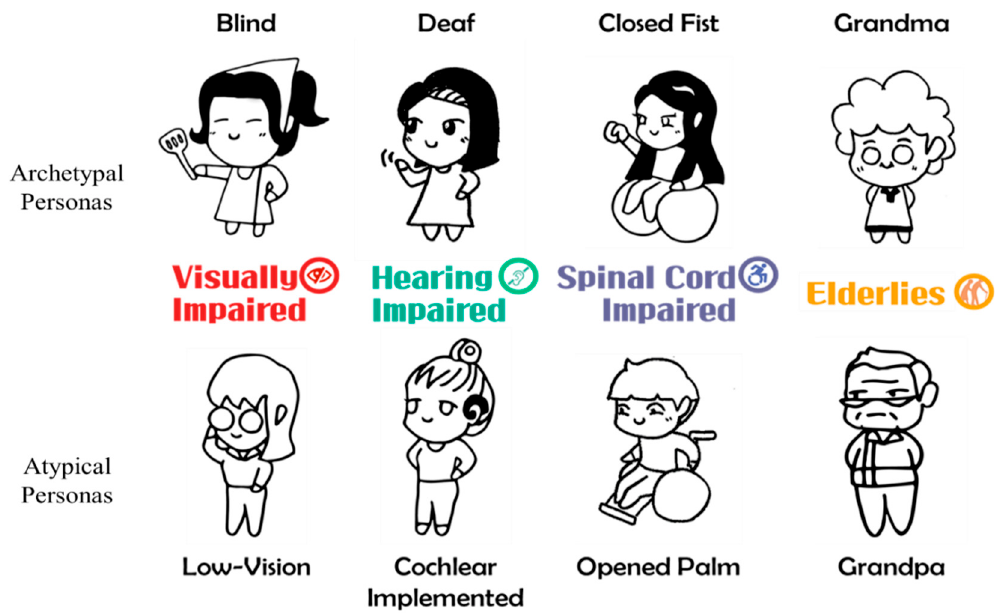
Figure 4. Eight personas created for four target user groups (archetypal and atypical personas).